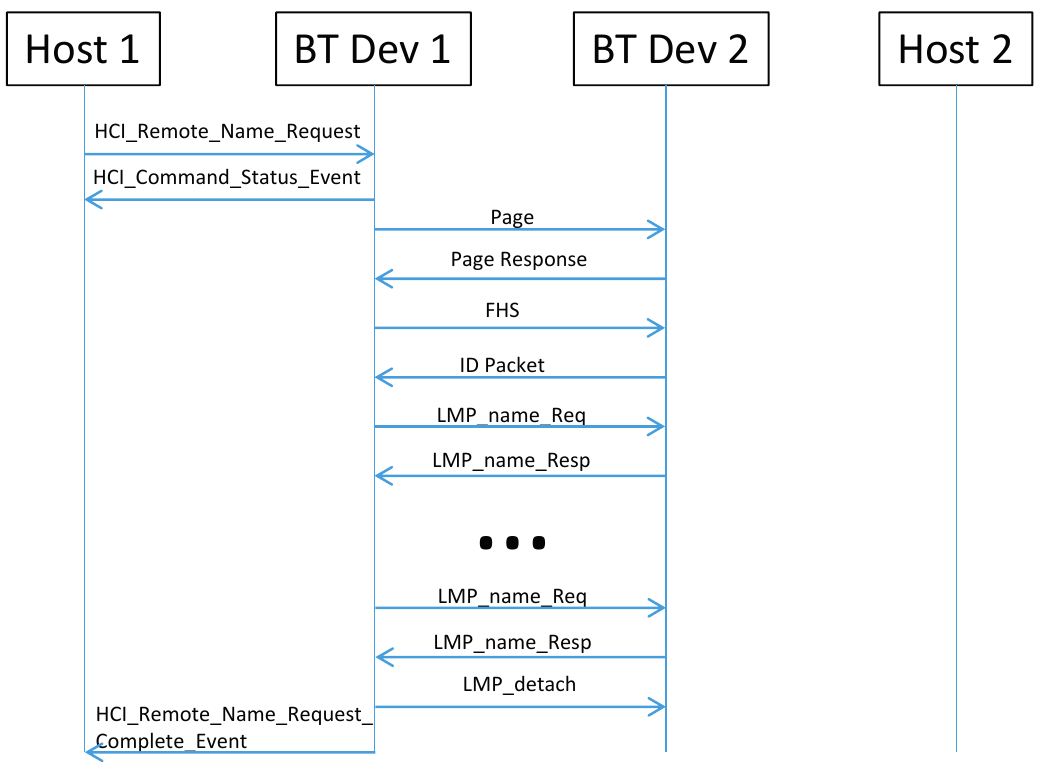
Figure 3. Remote Name Request